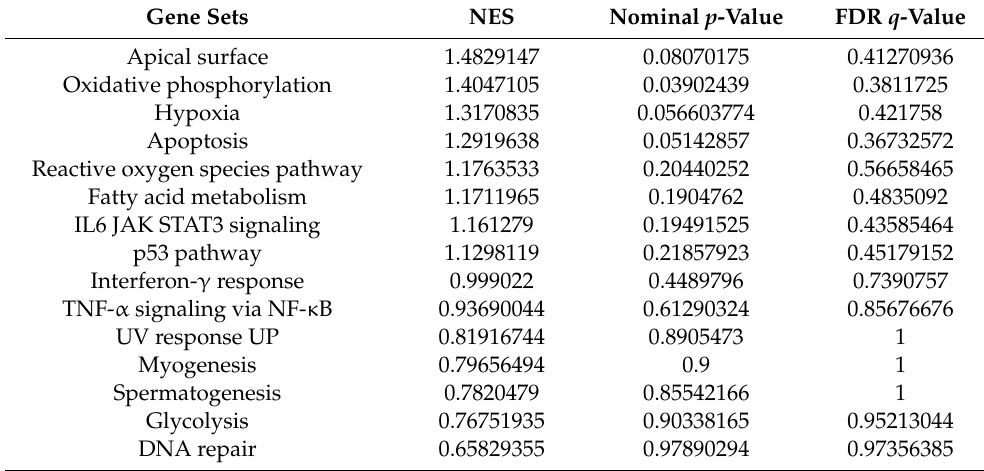
Table 1. Upregulated gene sets of the contralesional cerebellar cortex.